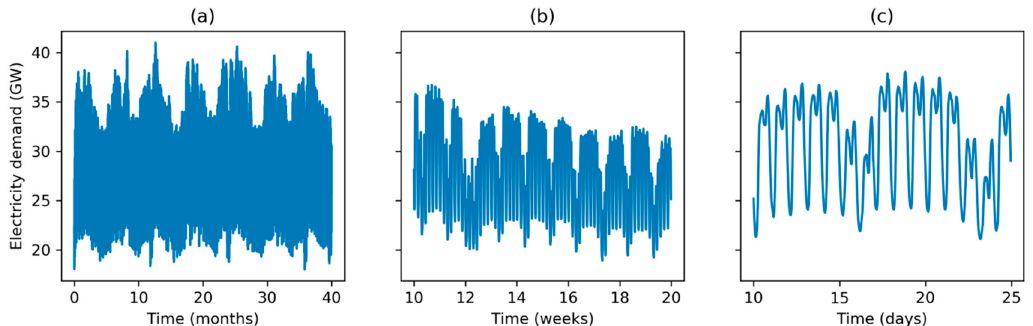
Figure 1. Electricity demand at different timescales. Monthly Hourly Load Values (MHLV) for Spain: ( a ) Overall dataset (40 months); ( b ) 10 weeks’ evolution; ( c ) 15 days’ demand.